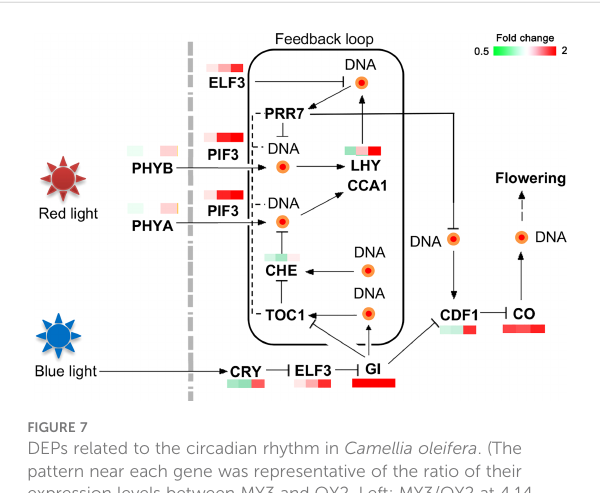
FIGURE 7 DEPs related to the circadian rhythm in Camellia oleifera . (The pattern near each gene was representative of the ratio of their expression levels between MY3 and QY2. Left: MY3/QY2 at 4.14, MY3/QY2 at 4.21, right: MY3/QY2 at